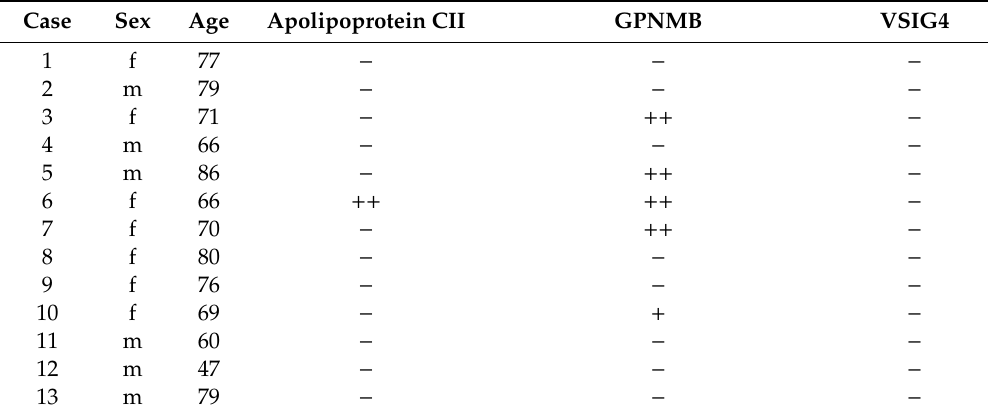
Table 7. Patients data and protein expression in PCNSL tissue (#1–20) and in normal brain (#21–25), respectively. Protein expression in tumor cells: − : Tumor cells negative; + : < 10% of tumor cells positive; ++ : 10–40% of tumor cells positive; +++ : > 40–80% of tumor cells positive; ++++ : > 80% of tumor cells